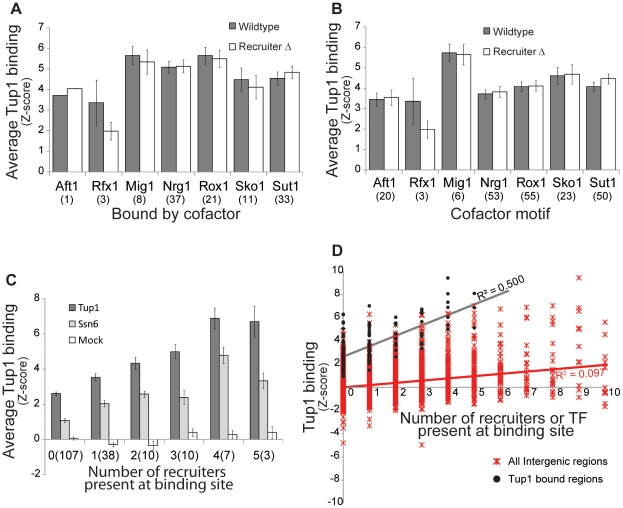
Deletion of individual Tup1 recruiters has little effect on Tup1 binding, and Tup1 binding is correlated with the presence of multiple recruiters.(A and B) The average enrichment (Z-score) in wild-type and recruiter deletion strains is plotted for (A) Tup1 targets bound (P<0.001) by a given transcription factor [30], or (B) Tup1 targets containing a binding site (P<0.005) for a given transcription factor [31]. To control for differences in IP efficiency between experiments Tup1 binding values were standardized to wild-type Tup1 binding by scaling Tup1 binding in each deletion strain so that the average Tup1 occupancy across all bound regions is the same for all experiments. The number of Tup1 targets in each group is indicated in parentheses and error bars represent standard error. (C) Tup1 targets were binned based on the number of recruiters bound to the target (P<0.001; [30]). Average enrichment (Z-score) for Tup1, Ssn6, or mock ChIPs for each group was calculated. The number of targets in each group is indicated in parentheses and error bars represent standard error. (D) Tup1 occupancy is plotted for Tup1 bound regulatory regions as a function of the number of bound recruiter proteins (Black) and for all regulatory regions, including the Tup1 bound regions, (Red) as a function of the number transcription factors bound at the regulatory region. The linear regression line and coefficient for both datasets is shown.